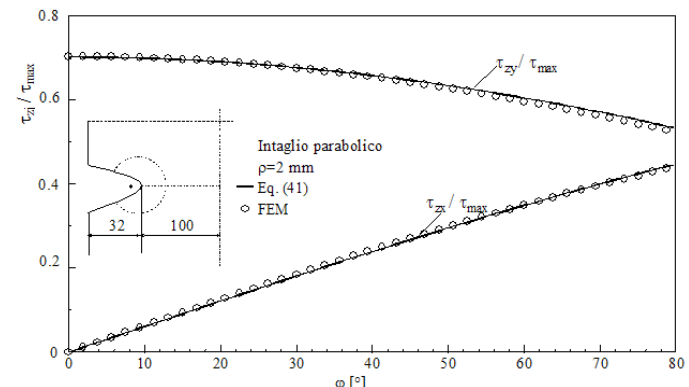
Figura 10: Campi di tensione su un percorso circolare di raggio pari a r =2 mm centrato sul fuoco dell’intaglio normalizzati rispetto alla tensione massima.